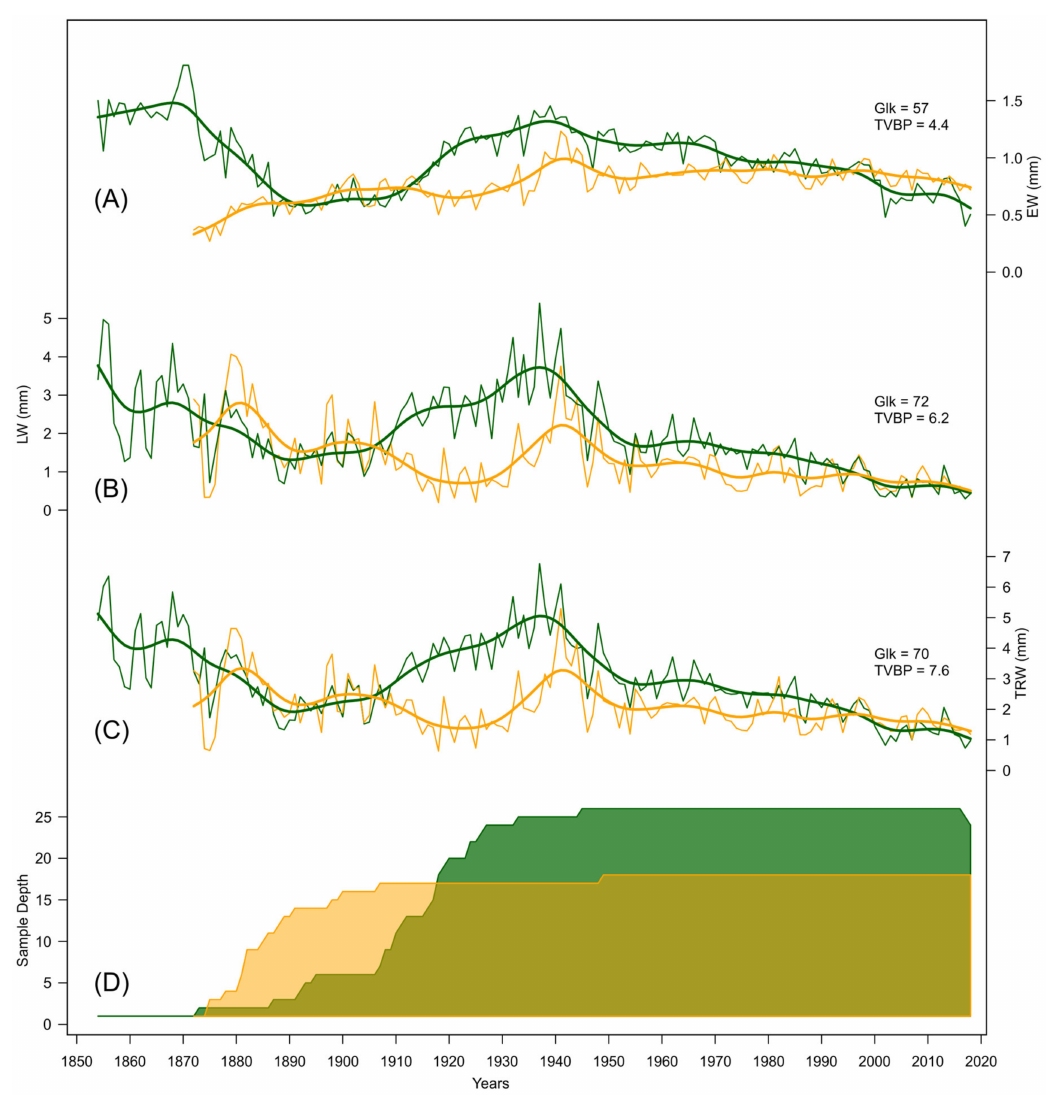
Figure 2. Mean growth widths chronologies: ( A ) earlywood (EW), ( B ) latewood (LW), ( C ) tree ring-widths (TRW), ( D ) sample depth; (ash—orange, oak—dark green, the thicker line refers to a 20 years low pass